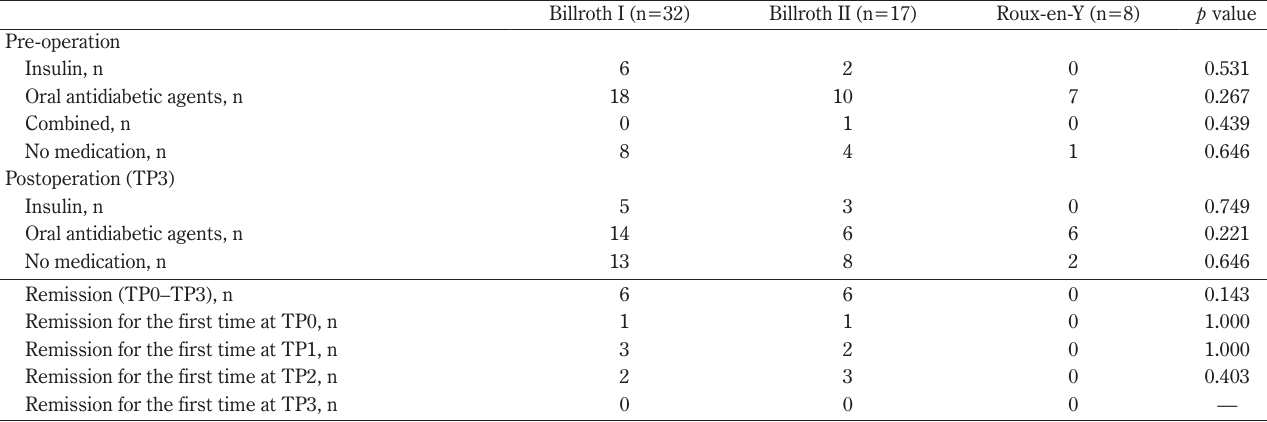
Table 6 Pre- and postoperative use of antidiabetic medication